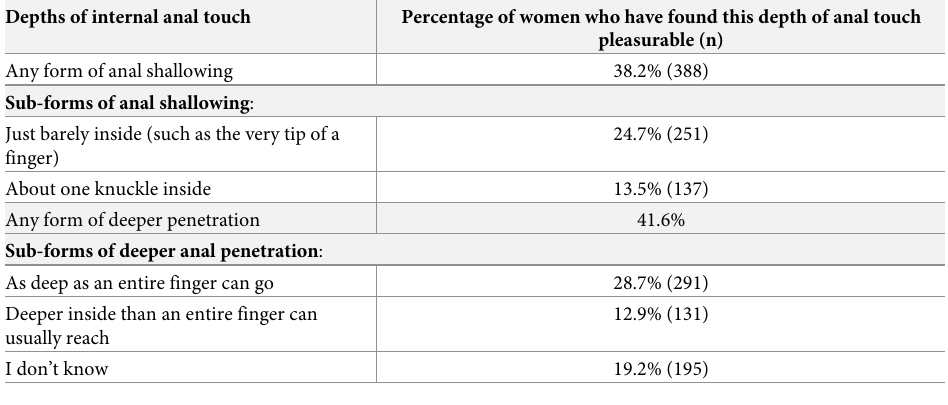
Table 4. Depths of internal anal touch found most pleasurable by women endorsing pleasure from any form of anal penetration (N = 1015, weighted) a . Depths of internal anal touch